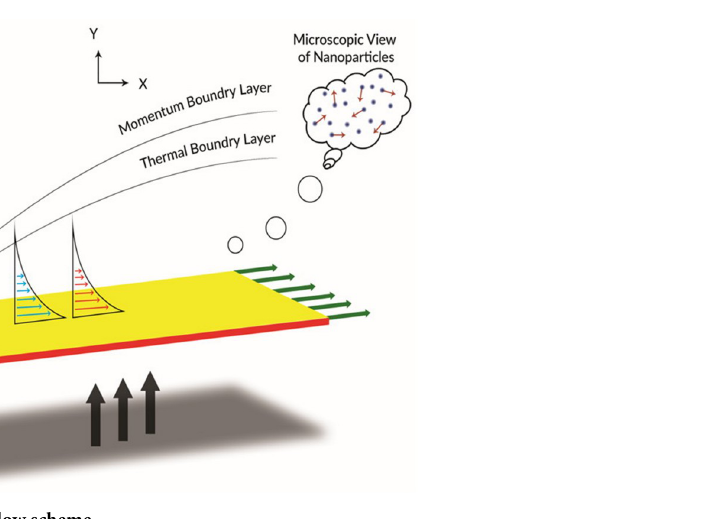
Fig 1. Diagram of the flow